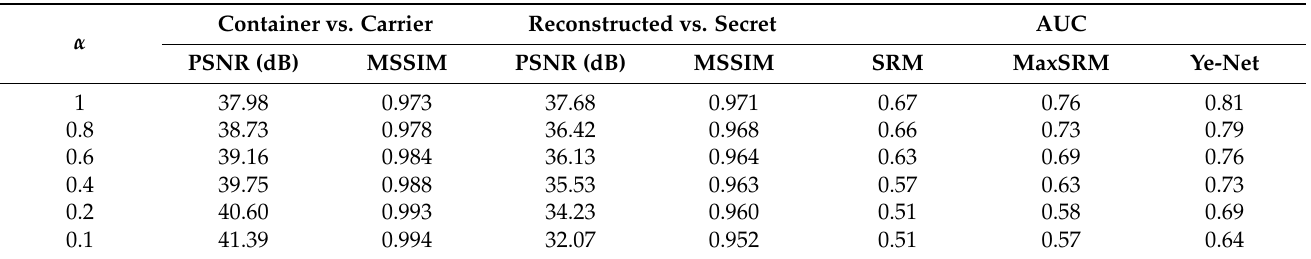
Table 4. Average PSNR and MSSIM between carriers and containers, as well as reconstructed secret images and secret images for different α values, and average AUC for attacking containers using different steganalysis algorithms.